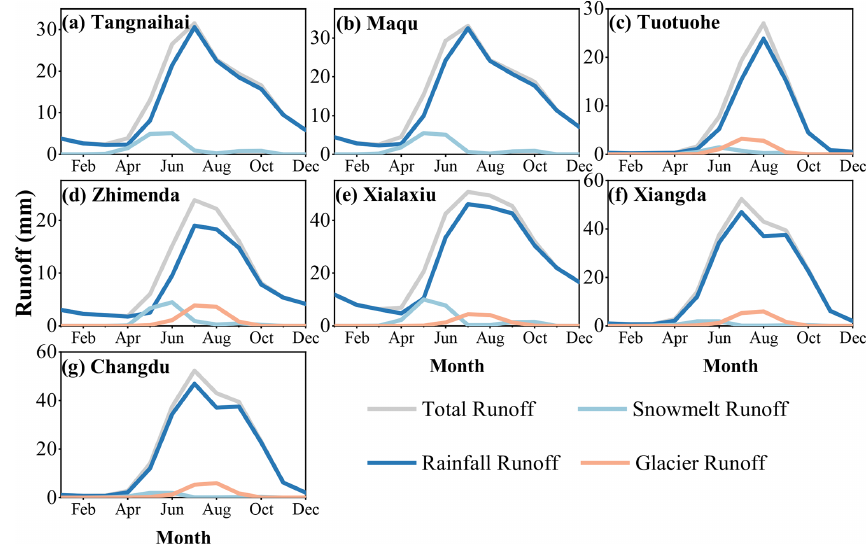
Figure 5. Seasonal cycles of simulated total, rainfall, snowmelt, and glacier runoff for the seven stations (a–g) during 1984–2018.